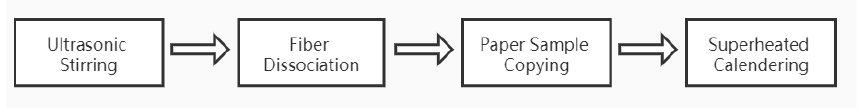
Figure 1. The whole modified aramid insulating paper sample preparation process.